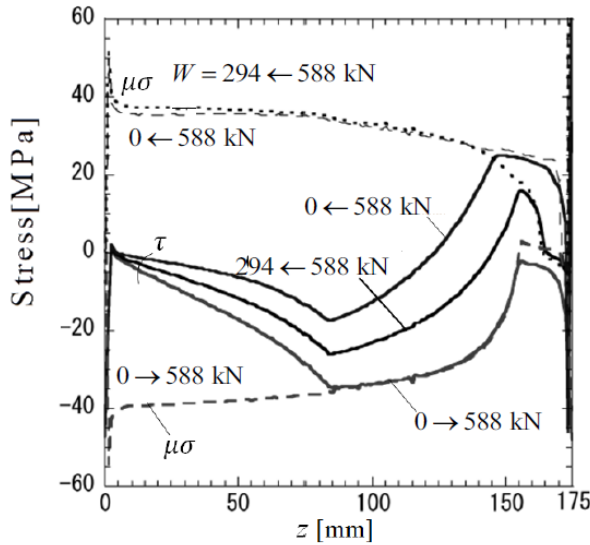
Figure 10. Deflection and residual deflection on arbor when load was reduced from 588 kN ( μ = 0.5).